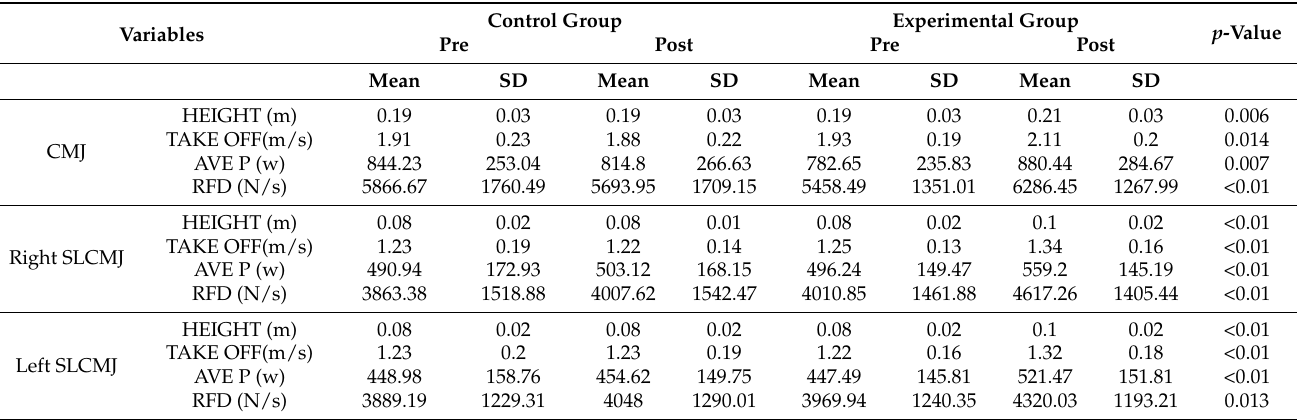
Table 4. CMJ, right SLCMJ, and left SLCMJ descriptive results and Post Hoc comparisons within subjects.